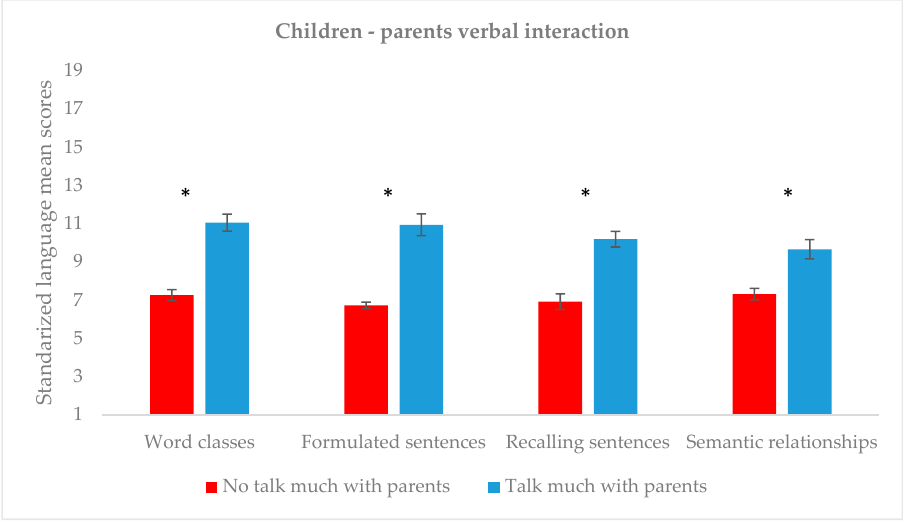
Figure 4. Mean language score and amount of verbal interaction with parents. * p < 0.001.